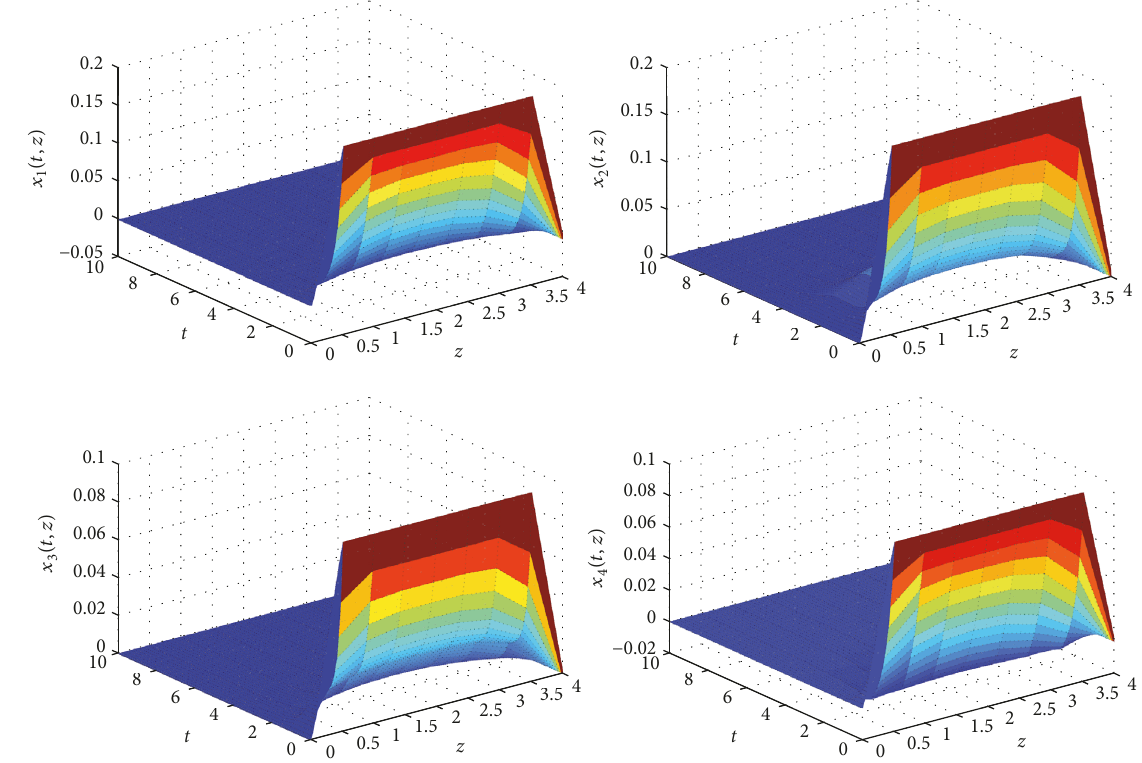
Figure 1: The trajectories of mRNA concentrations 𝑥(𝑡, 𝑧) for the genetic regulatory networks (8).